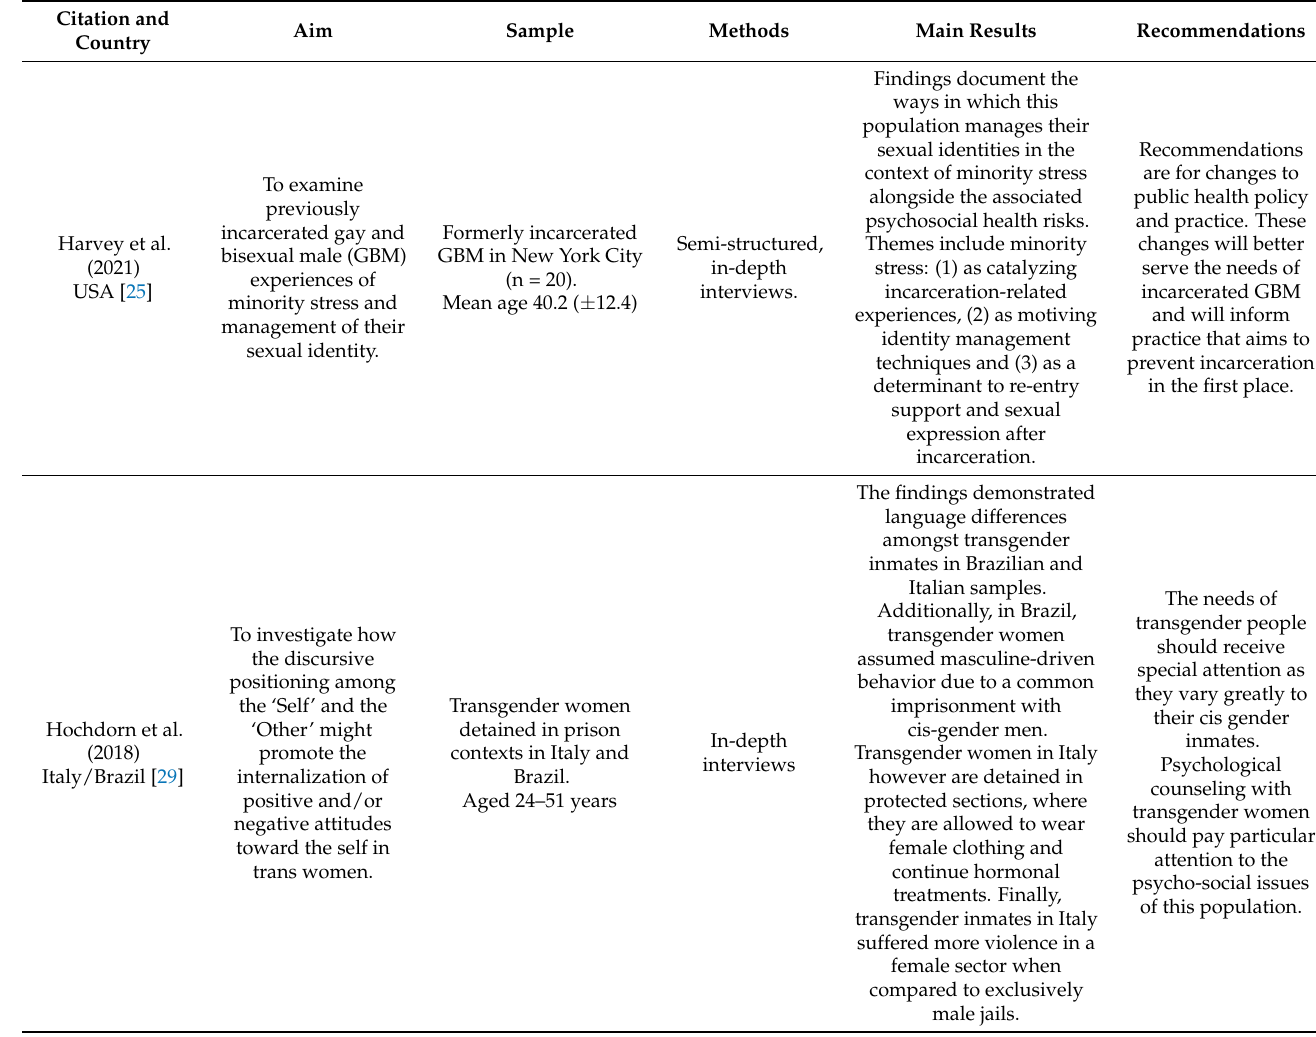
Table 3. Papers included in the review (n =